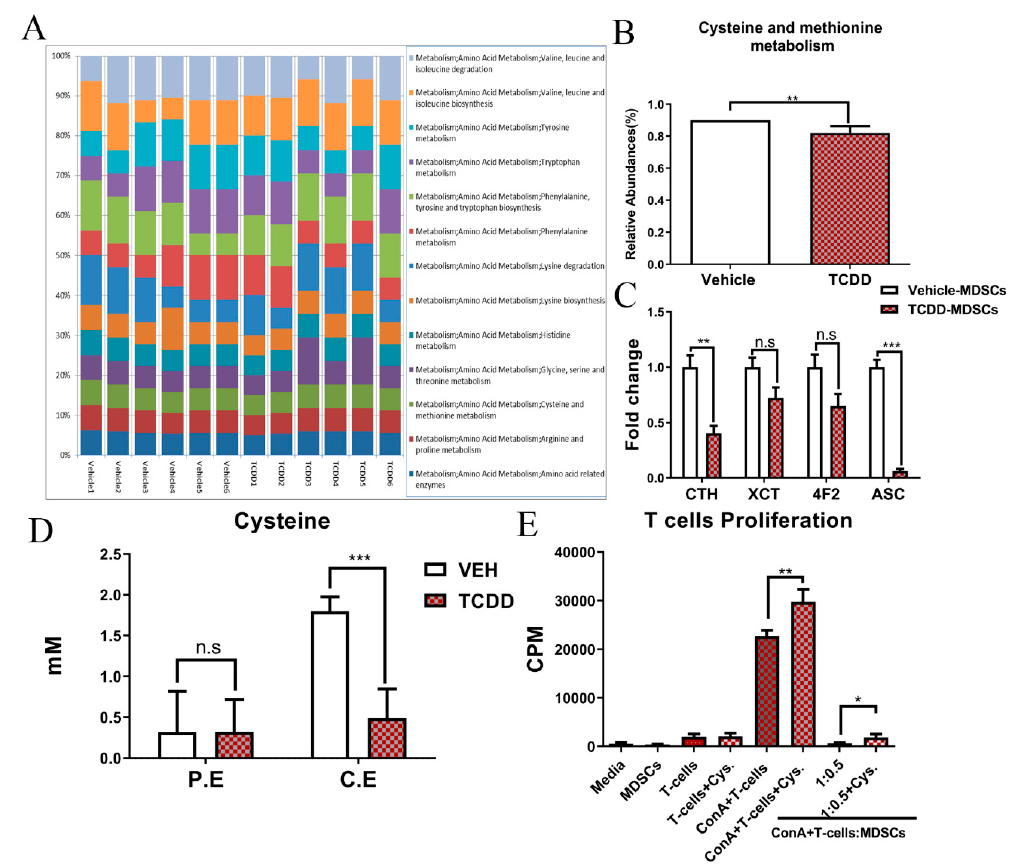
Figure 3. Role of cysteine in TCDD-mediated immunomodulation. C57BL / 6 mice were treated with TCDD (10 µg/kg) or vehicle and feces were collected for 16S rRNA sequencing. ( A ) Phylogenetic Investigation of Communities by Reconstruction of Unobserved States (PICRUSt) data from Nephele depicting KEGG pathways altered in vehicle ( n = 6) and TCDD ( n = 6) gut microbiome. ( B ) Percent of OTUs attributed to cysteine and methionine metabolism. ( C ) qPCR quantification of alanine-serine-cysteine transporter (ASC) neutral amino acid transporter, XCT (light chain of